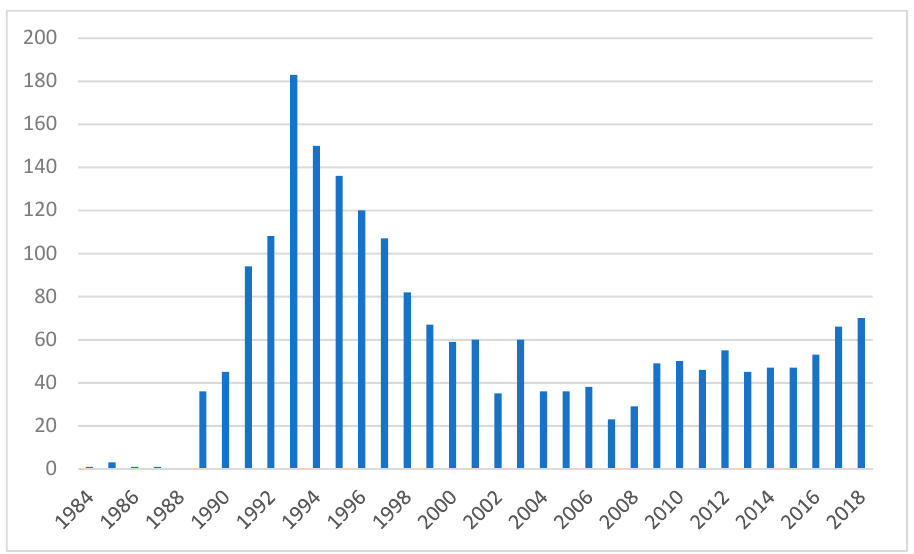
Figure 1. Scopus-indexed articles with “Total Quality Management” in the title.